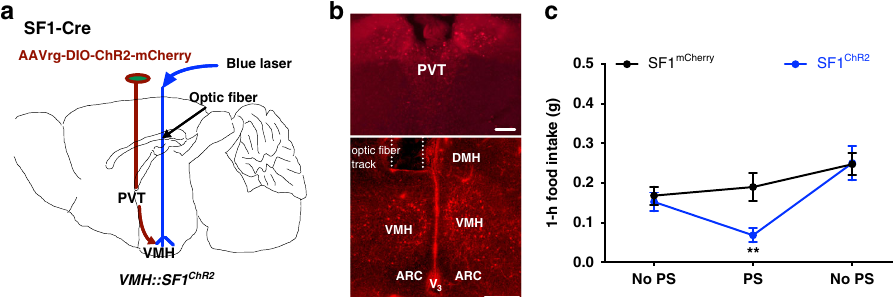
Fig. 3 PS of PVT-projecting SF1 neurons inhibits food intake. a Schematic illustration of retrograde tracing and transducing PVT-projecting SF1 neurons in the VMH with ChR2-mCherry, and an optic fi ber above VMH for PS of the retrograde traced SF1 neurons in SF1-Cre mice. b Sample images showing the retrograde traced PVT-projecting VMH SF1 neurons (bottom) and their projections to PVT (top). c Group data of 1 h food intake before, during, and after the PS: PS of PVT-projecting SF1 neurons in the ChR2 retrograde traced and transduced mice ( n = 7 males and 6 females) potently inhibited food intake as compared to control mice ( n = 7 males and n = 7 females; p = 0.0058, mCherry vs ChR2 PS ). Two-tailed Student ’ s t -tests; data represent mean ± s.e.m.; ** p < 0.01; n.s. not signi fi cant. Scale bars, 200 μ m for b (top) and 100 μ m for b (bottom). ARC arcuate nucleus, DMH dorsomedial hypothalamus,